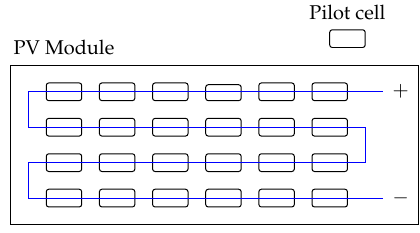
Figure 2. Pilot cell